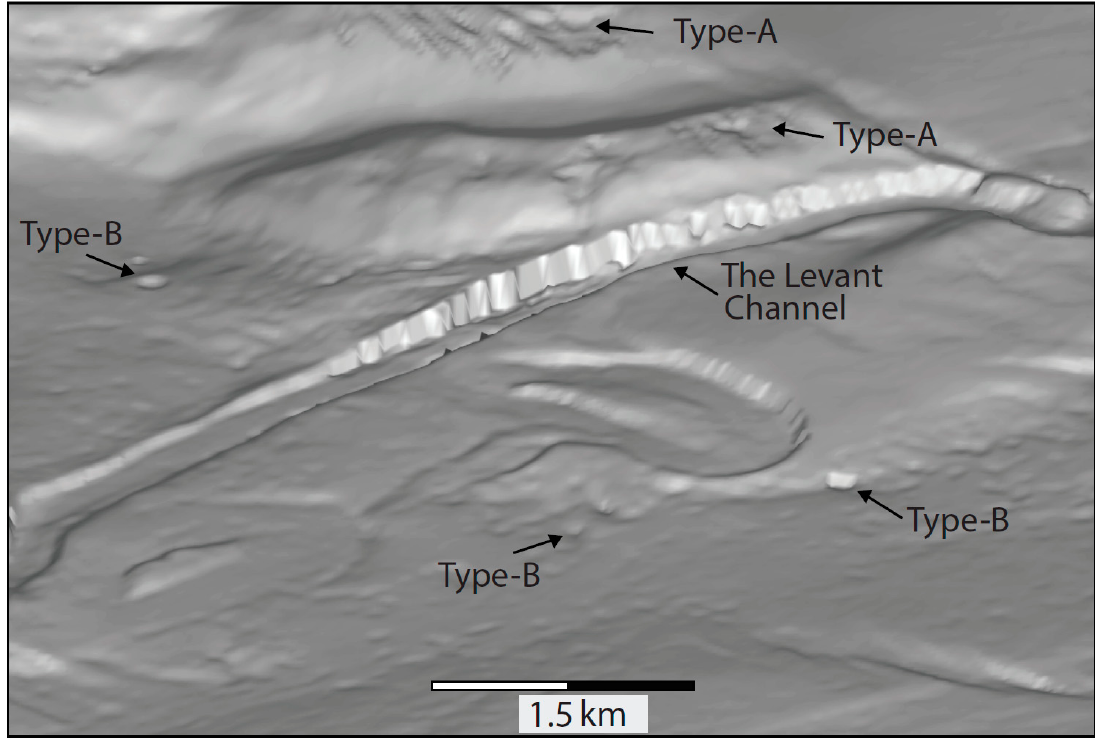
Figure 5. A 3D shaded relief view of the high-resolution bathymetry, extracted from the Southern Israel 3D seismic data, across the southern part of the Levant channel within the Southern Israel block (see Figure 1 for position), viewed from the northwest. The pockmarks observed are classified into two types based on their sizes and morphologies. Type-A are oddly shaped large (hundreds of meters) scale pockmarks, while Type-B are generally rounded pockmarks ranging in diameter between 50 to 150 m.